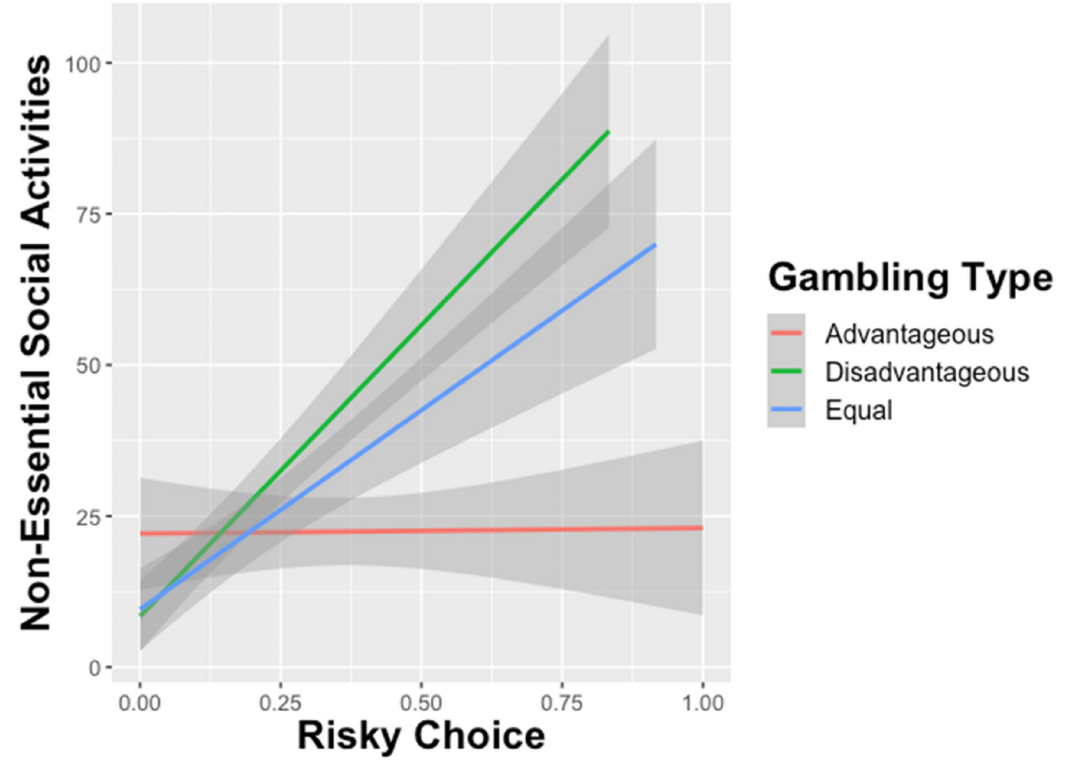
Fig 3. Effect of risky choice on number of interpersonal social interactions by gambling type. Advantageous gambles indicate that the expected value for the risky choice was higher than the safe gamble. Disadvantageous gambles indicate that the expected value for the risky option was lower than the safe option, and the expected values for both safe and risky choices were the same for Equal gambles. Higher proportion of Disadvantageous and Equal risky choices predicted greater engagement in non-essential social activities, an indicator of reduced social distancing